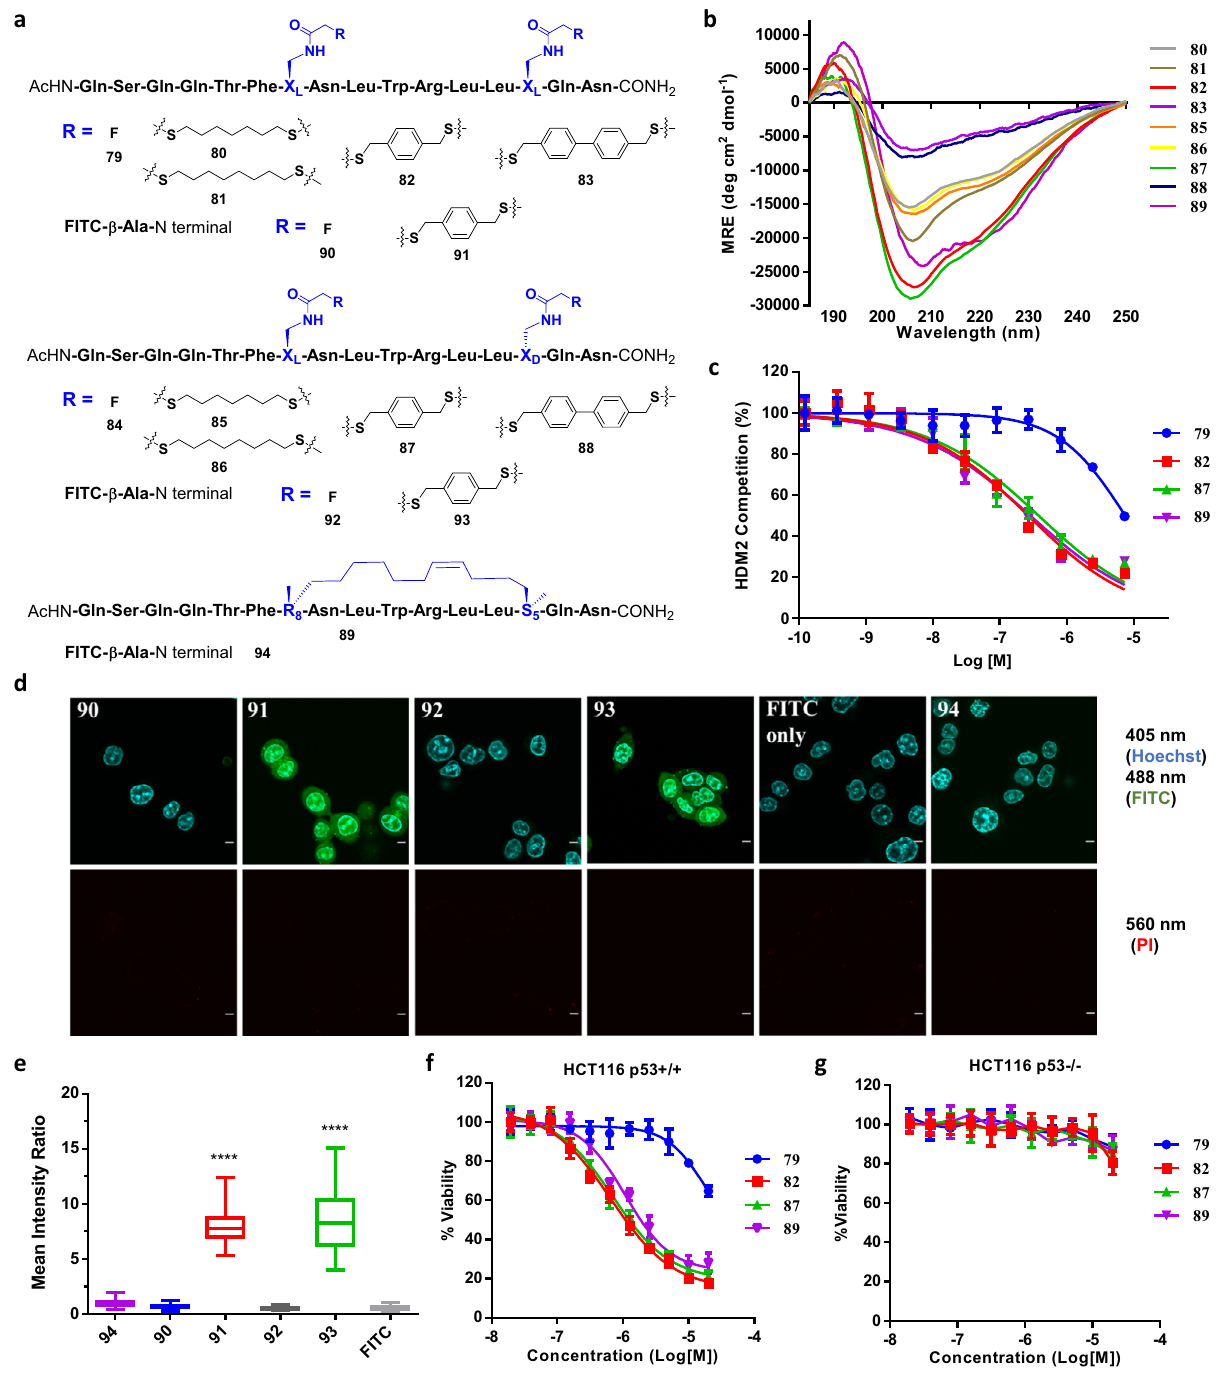
Fig. 8 FTDR-stapled p53 peptide analogues. a FTDR coupling between unprotected p53 peptide analogues ( 79 , 84 ) and various dithiol linkers with i , i + 7 linkage. The reported p53 peptide analogue 89 was prepared based on RCM stapling. Coupling residues X L /X D /R 8 /S 5 are highlighted in blue. Peptides 90 – 94 are the N-terminal FITC labelled versions of peptide 79 , 82 , 84 , 87 , and 89 . b CD spectra of all crosslinked p53 peptide analogues. c ELISA assay of stapled p53 peptide analogues ( 82 , 87 , RCM control 89 ) and the unstapled control 79 for their inhibition of p53-HDM2 interaction. Data represents mean values ± SD ( n = 3 independent samples). d Fluorescent confocal microscopy images of the wild type HCT116 cells treated with the N-terminal FITC labelled peptides 90 – 94 and FITC as a negative control. Blue (405 nm channel): nucleus stained by Hoechst 33342; Green (488 nm channel): FITC; Red (560 nm channel): propidium iodide staining; Scale bar: 5 μ m. e Quanti fi cation analysis of the cell penetration of peptides 90 – 94 ( n = 159 for 94 , n = 144 for 90 , n = 163 for 91 , n = 134 for 92 , n = 155 for 93 , n = 148 for FITC only). The mean intracellular intensity of the RCM-stapled peptide 94 was normalized as 1. Box plots show 25 – 75% quantiles, median values (bullseye), and minimal and maximal values (whiskers). Two-sided unpaired t test with Welch ’ s correction has been applied. “ **** ” Represents p < 0.0001. f – g Cell viability assays in p53 wild-type HCT-116 cells ( f ) and p53 null HCT-116 cells ( g ) treated with well-stapled p53 peptide analogues. Data plots are mean values ± SD based on n = 3 independent samples.